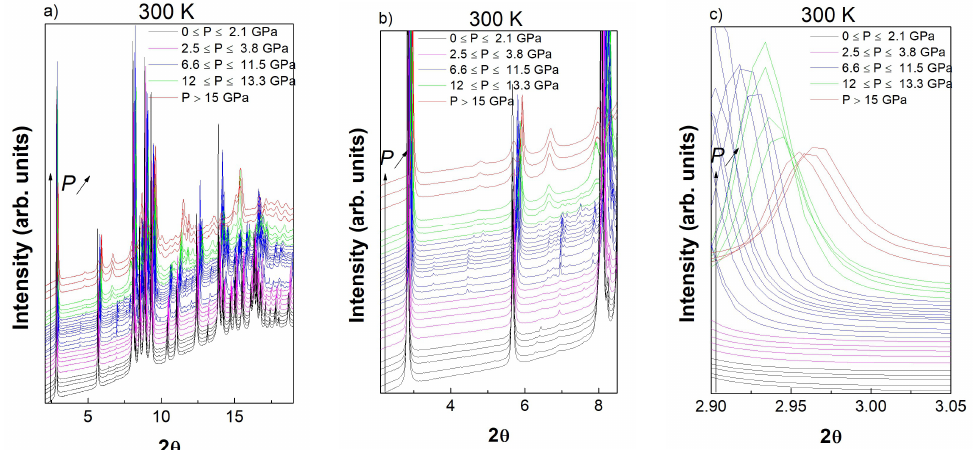
Figure 3. Pressure dependence of the LuFe 2 O 4 X-ray data at 298 K, (a) full-2 ϴ -range, (b) 2°–8.5°-2 ϴ -range, (c) 2.9°–3.05°-2 ϴ -range.